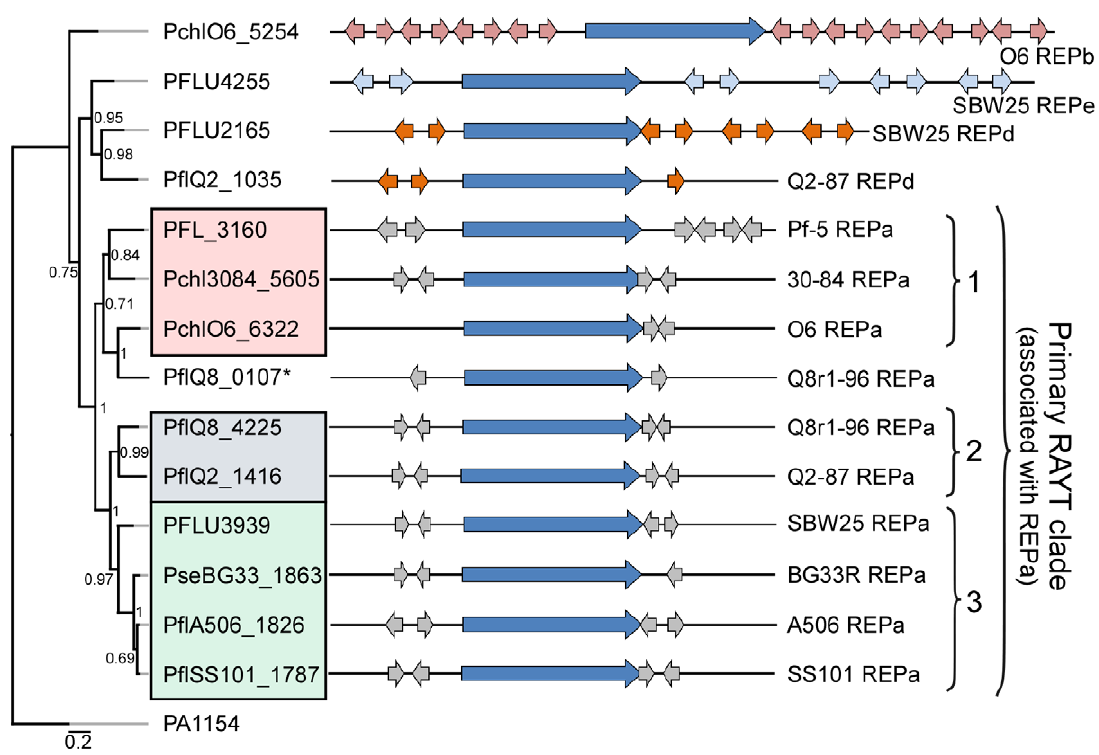
Figure 4. Repeated extragenic palindromic (REP) elements and REP–associated tyrosine transposases (RAYTs) of the P.fluorescens group. The left panel shows a phylogenetic tree, generated using the MrBayes package [152], depicting the relationships between RAYT proteins identified within each strain of the P. fluorescens group. The interior node values of the tree are clade credibility values, which represent the likelihood of the clade existing, based on the posterior probability values produced by MrBayes. The locus tags for primary RAYT proteins are shaded according to sub-clade using the color scheme of Figure 1; locus tags for secondary RAYT proteins are not shaded. The second primary RAYT in Q8r1-96 is within PflQ8_0107, in a separate reading frame. The right panel shows schematic representations of the RAYT genes (dark blue arrows) and the locations of associated flanking REP elements (REPa sequences in grey; REPd in orange; and REPe in light blue). The P. aeruginosa RAYT protein encoded by PA1154 is used as an outgroup, since this RAYT protein was shown previously to fall within a clade separate from the P. fluorescens RAYT proteins [44].